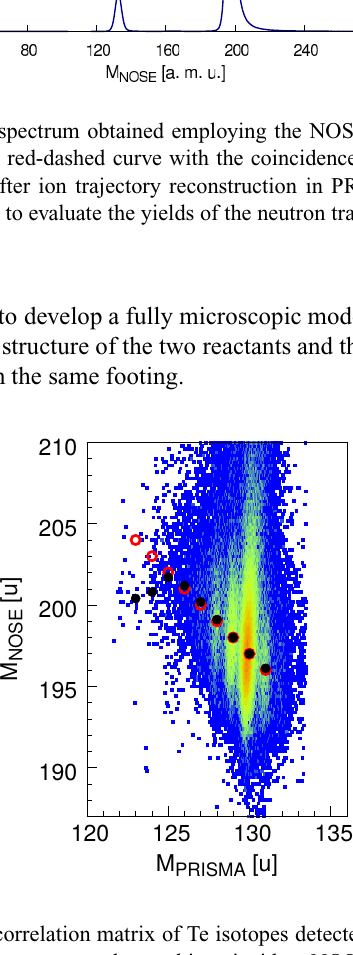
Figure 5. Mass-mass correlation matrix of Te isotopes detected in PRISMA and the heavy partner detected in coincident NOSE detector. The red (empty) circles indicate the centroids of the correlated masses of the primary neutron transfer channels, the black (full) dots indicate the experimental centroids as derived from the fits of their projections.